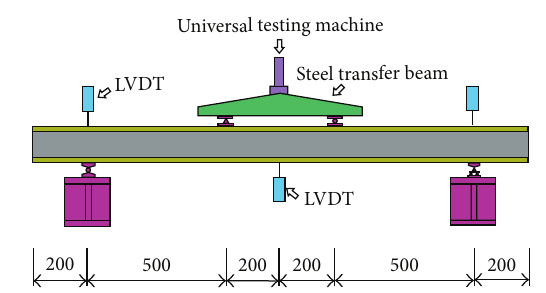
Figure 2: Schematic illustration of the test.